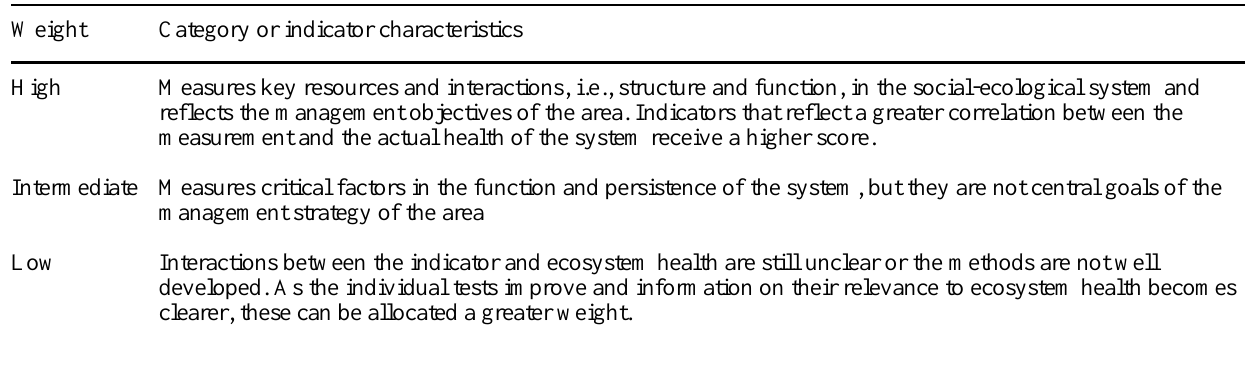
Table 1. Rationale for the holistic ecosystem health indicator weighted point system. Source: Aguilar (1999). Weight Category or indicator characteristics